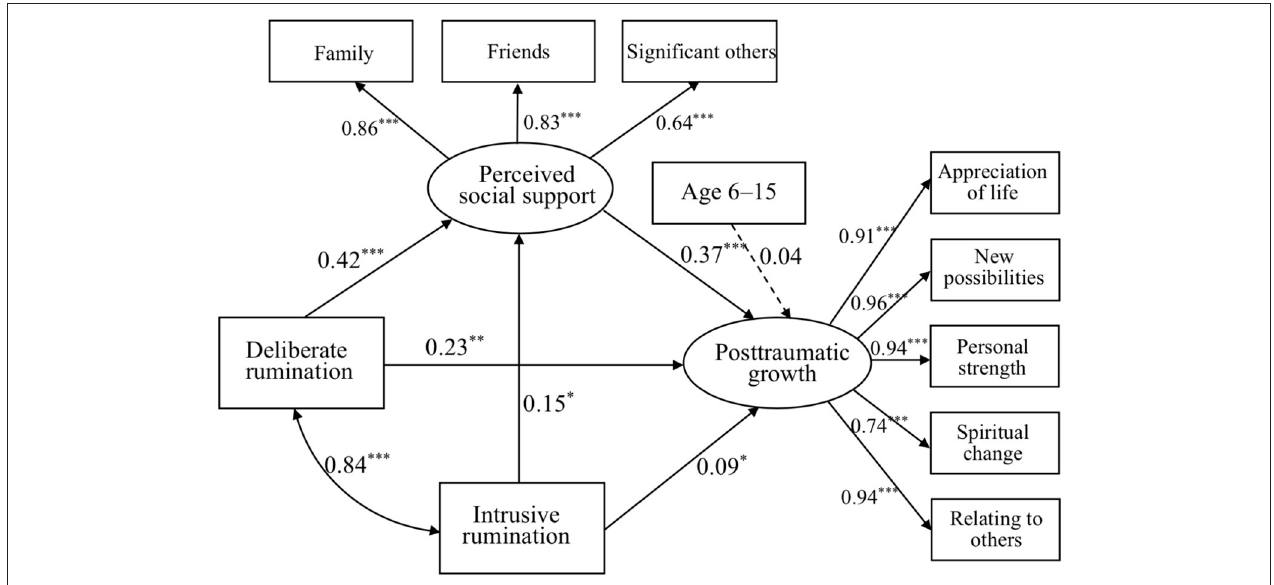
FIGURE 2 | Mediation model of deliberate and intrusive ruminations to PSS and to PTG in age 6–15 sample. * p < 0.05, ** p < 0.01, and *** p < 0.001.